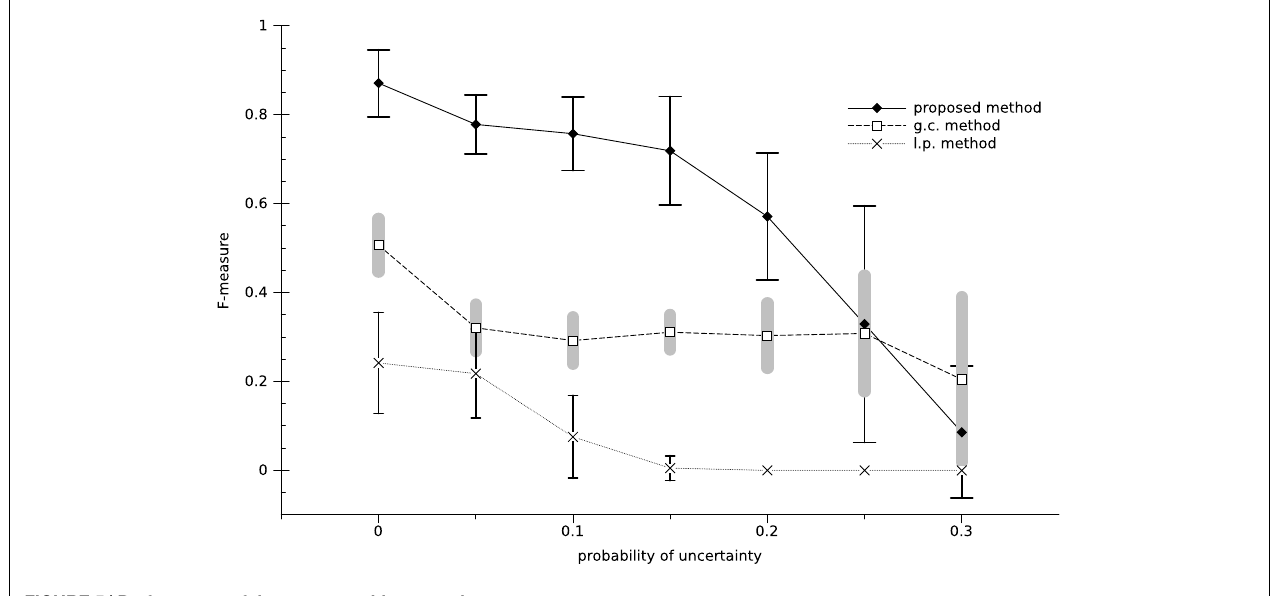
FIGURE 5 | Performance of the systems with uncertainty .